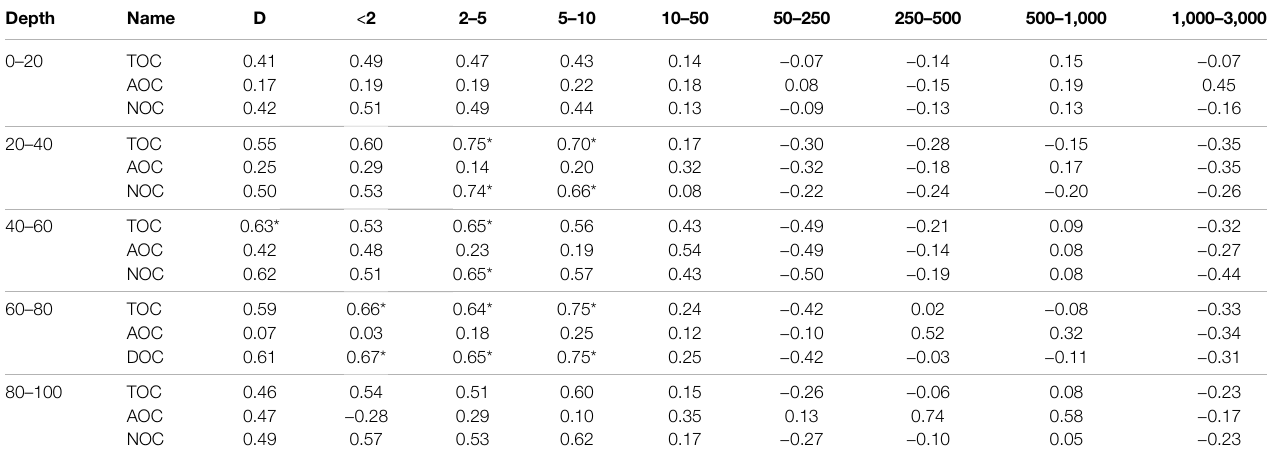
TABLE 6 | Correlation analysis between the soil particles and SOC in the woodland in the non fl ooded area.